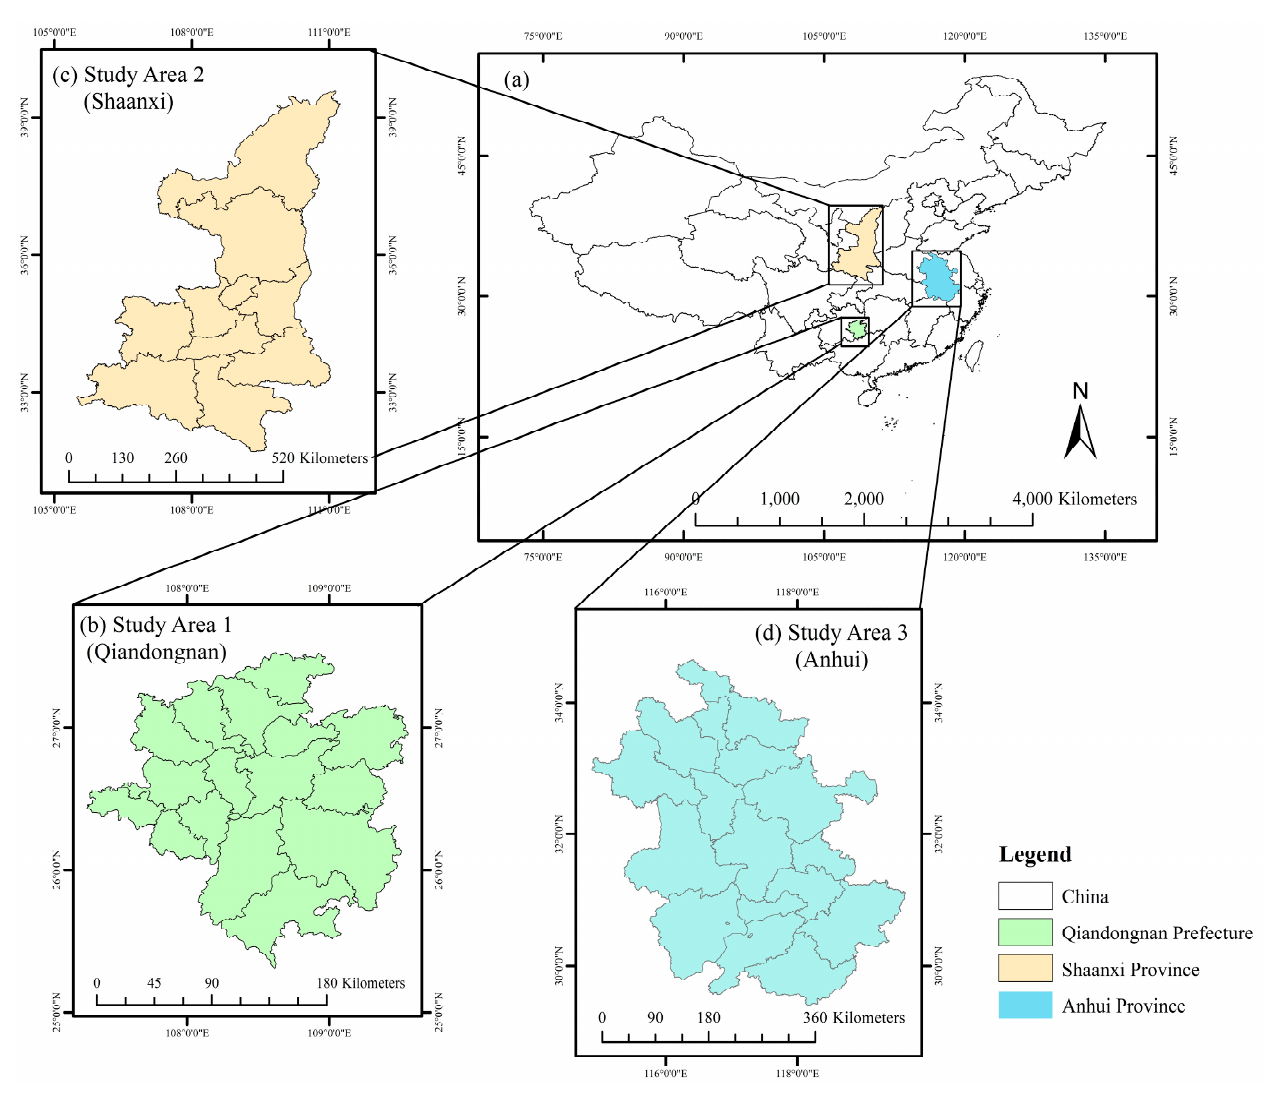
Figure 2. Location of the three researched areas. ( a ) The provincial boundaries of China; ( b ) the location of the Qiandongnan Miao and Dong Autonomous Prefecture; ( c ) the location of the Shaanxi Province; ( d ) the location of the Anhui Province. Table 1. The number of TCSs for each environmental pattern in the three